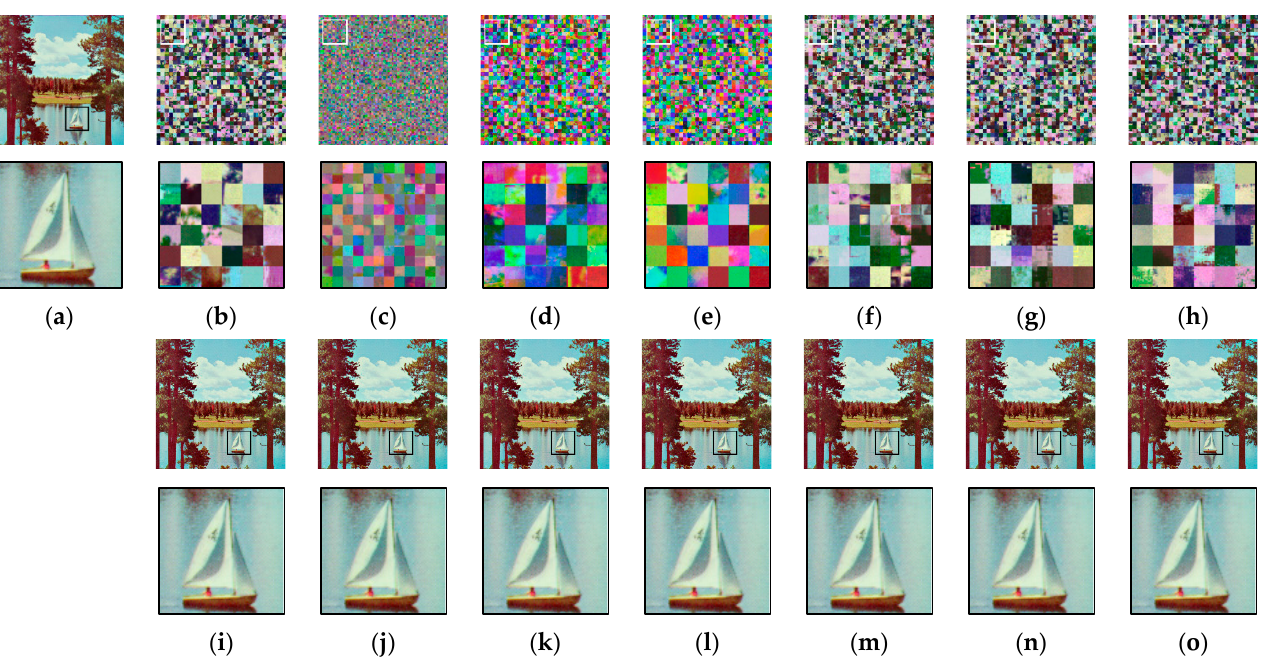
Figure 20. Visual analysis of the images recovered from the CPE processing. ( a ) The original image.